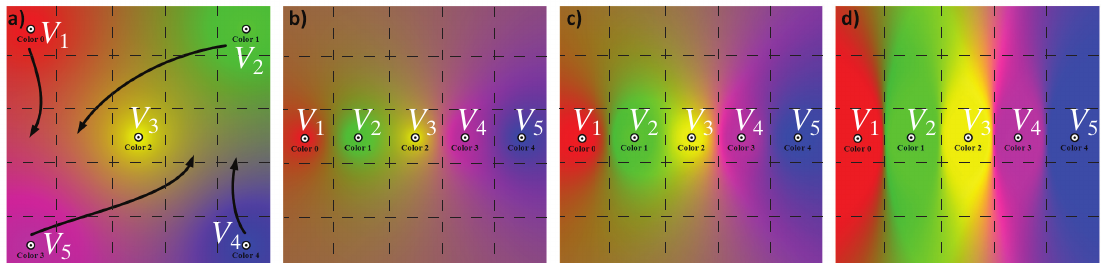
Figure 3. Thumbnail grid and view interpolation. Each image shows a set of five preset views V 1 . . . V 5 arranged on a five by five grid. The views are simple color pixels for illustration purposes. Each grid pixel is colored to reflect what the interpolated view would be at that position. ( a ) Initial placement of the preset views; ( b ) Effect of dragging the views along the arrows shown in ( a ); ( c , d ) Effect of setting p = 1 and p = 0.5, respectively. The grids ( a , b ) use the default p =